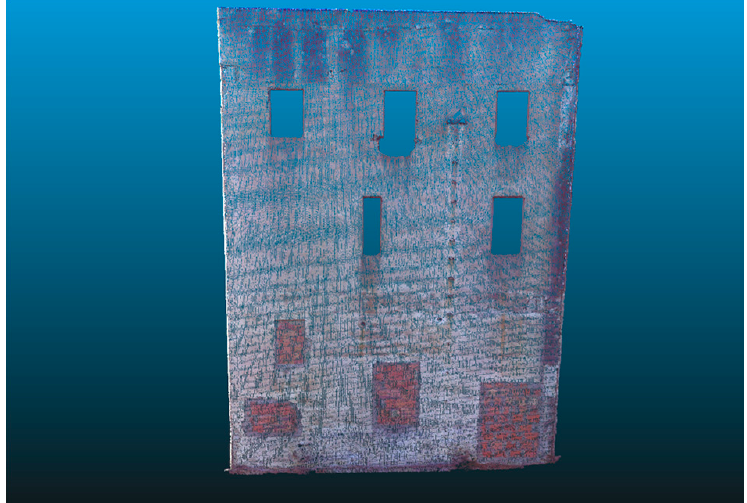
Figure 20. TLS point